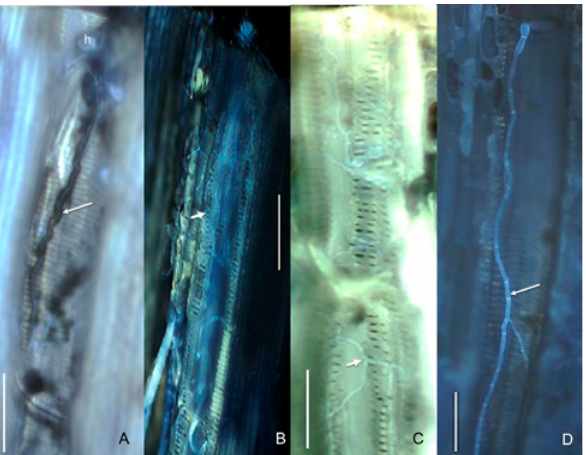
Figure 8. Longitudinal sections of grapevine stems inoculated with pycnidiospores of Lasiodiplodia gilaniensis (A and B), Diplo- dia seriata (C) or D. corticola (D), observed using epifluorescence microscopy 48 h after inoculation. In L. gilaniensis , degradation of the cell wall of a vessel (A) and colonization of the xylem vessels (B) were observed. C, Hyphal branches inside the trachea coloniz- ing a vessel and using pits as anchorage sites. D, Hyphal branches growing along the trachea. X) xylem vessel; h) hyaline pycnidi- ospores, arrow) hypha. Bars = 50